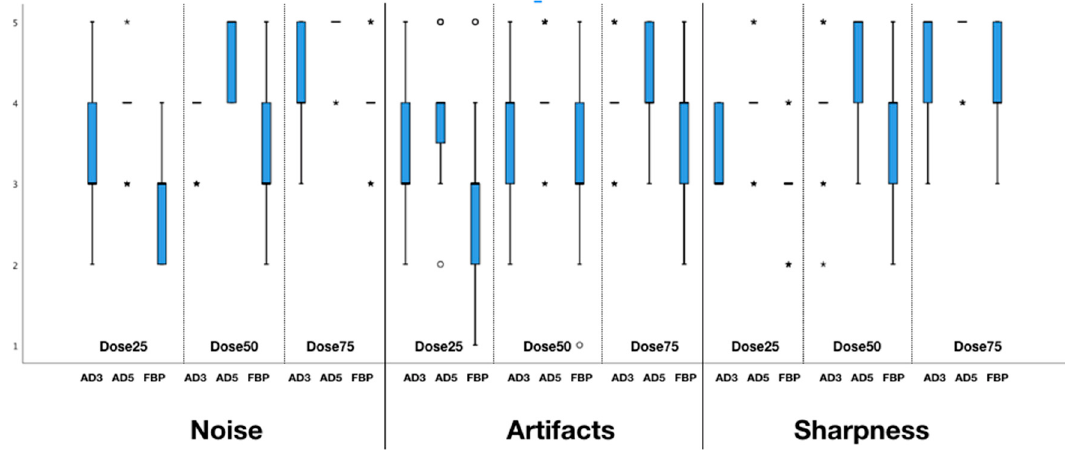
Figure 3. Artifacts, sharpness, and noise at different dose levels and reconstructions: Given is the median of ADMIRE 3, ADMIRE 5, and FBP.